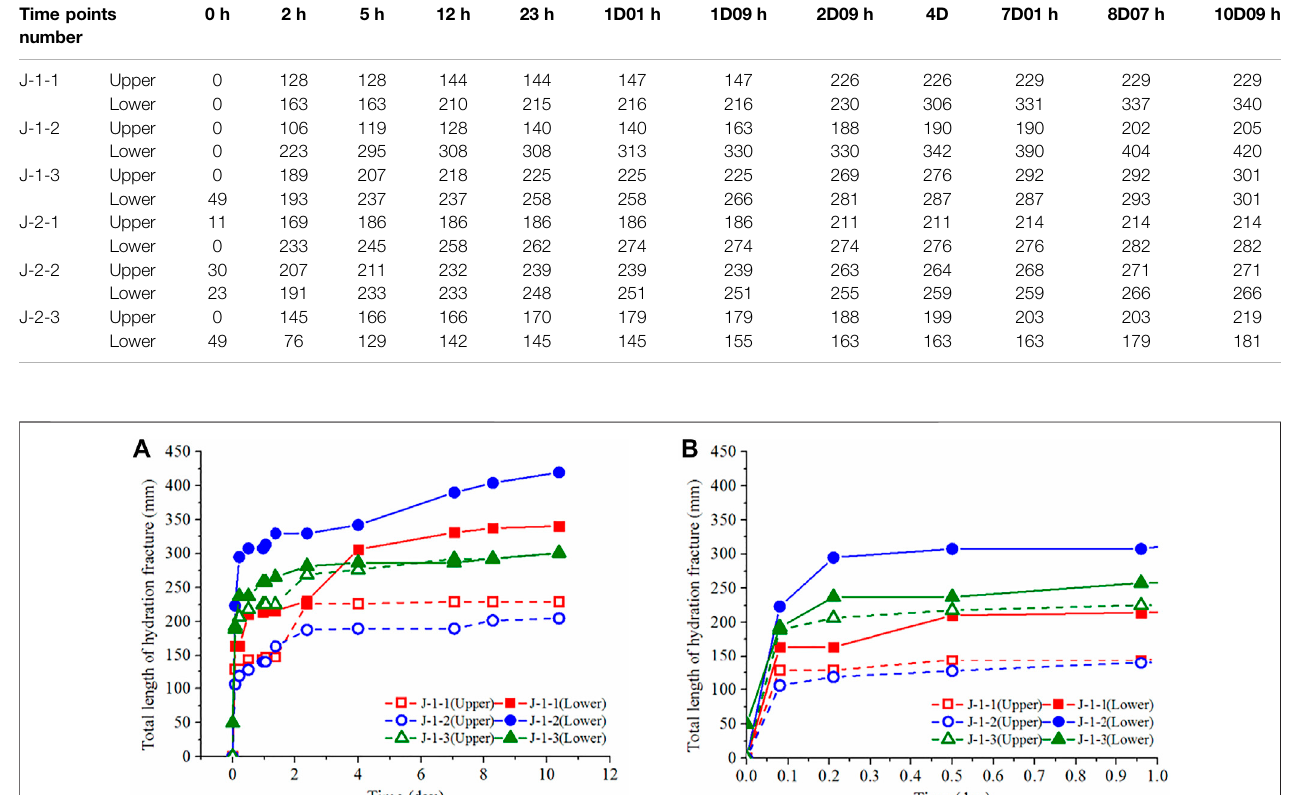
Frontiers in Earth Science |